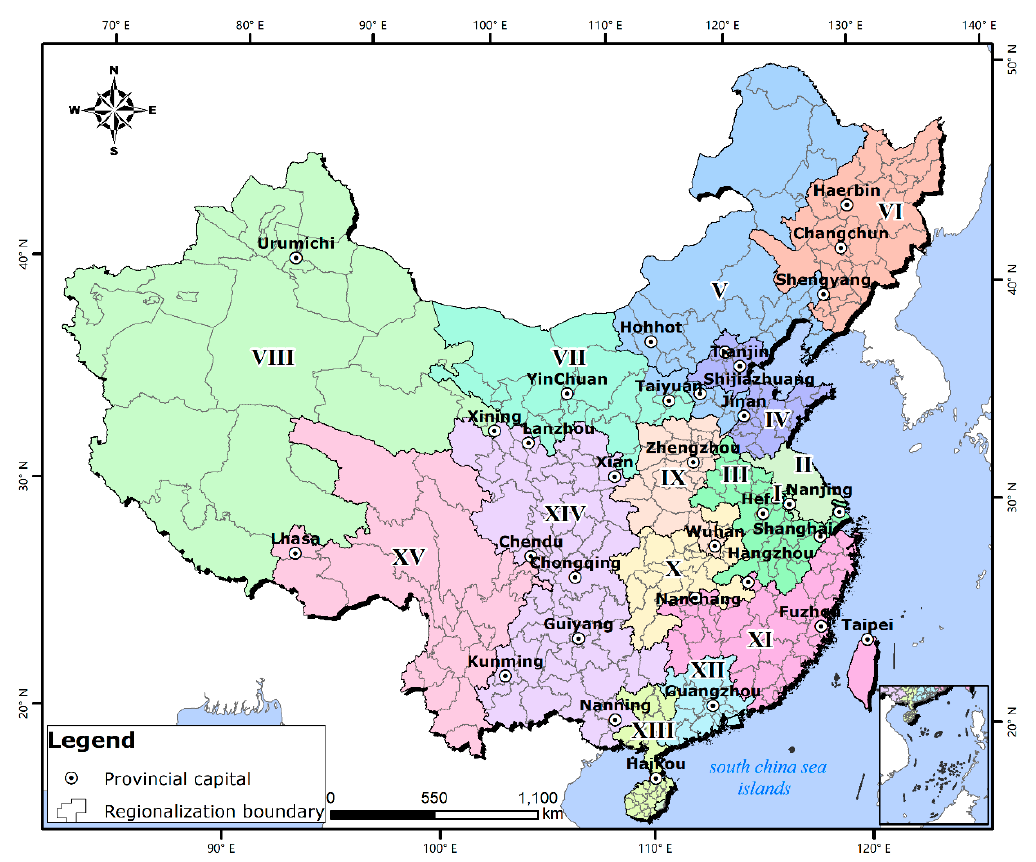
Figure 2. Regionalization results of tourist flow intensity. The whole of China is divided into 15 regions, and each division is coded in Roman numerals.